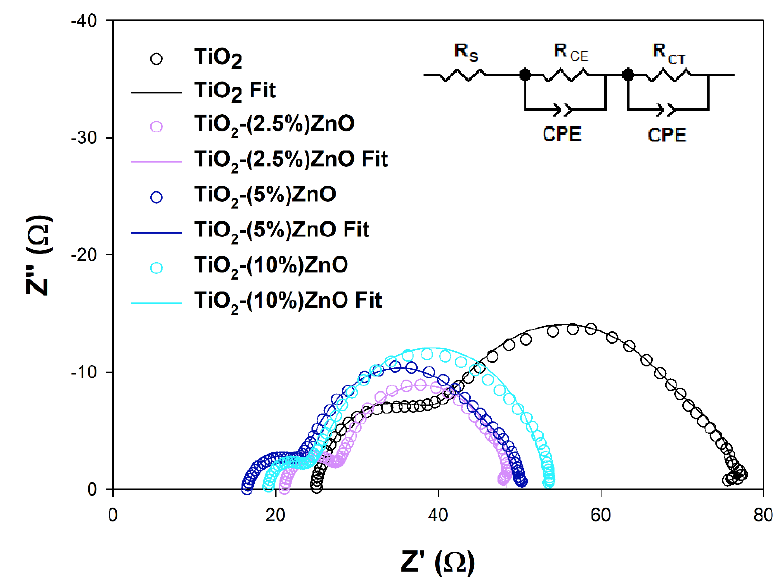
Figure 16. Nyquist plots of the EIS results registered for investigated cells and the scheme of equivalent circuits used for the results fitting. Table 7. EIS parameters and the amounts of adsorbed dyes’ molecules of DSSCs utilizing TiO 2 - ZnO photoanodes.